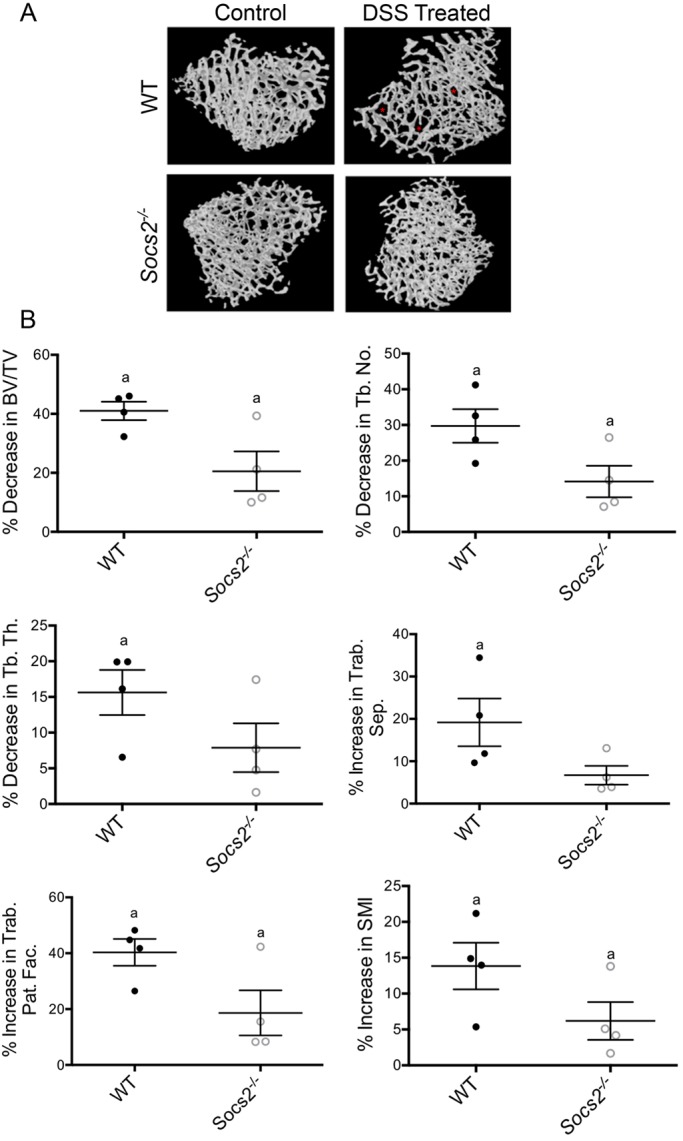
Trabecular bone architecture of DSS-treated WT and Socs2−/− mice. (A) Representative 3D μCT reconstructions showing a less-compact trabecular architecture resulting in a more porous structure (*) in DSS-treated WT mice compared to WT control mice. A similar alteration in bone architecture was not observed in DSS-treated Socs2-deficient mice. (B) Percentage change of trabecular parameters in DSS-treated mice relative to genotype-matched controls. Data are presented as means±s.e.m. (n=4). aSignificantly different from genotype-matched control (P<0.05) by nonparametric test (Mann–Whitney). BV/TV, bone volume/tissue volume; Tb., trabecular; Th., thickness; Pat. Fac., pattern factor; SMI, structural model index.